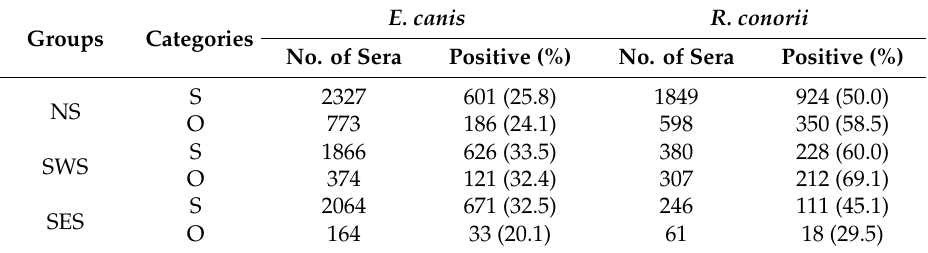
Table 4. Serological results in relationship to dog population: Shelter (S) or owned (O)